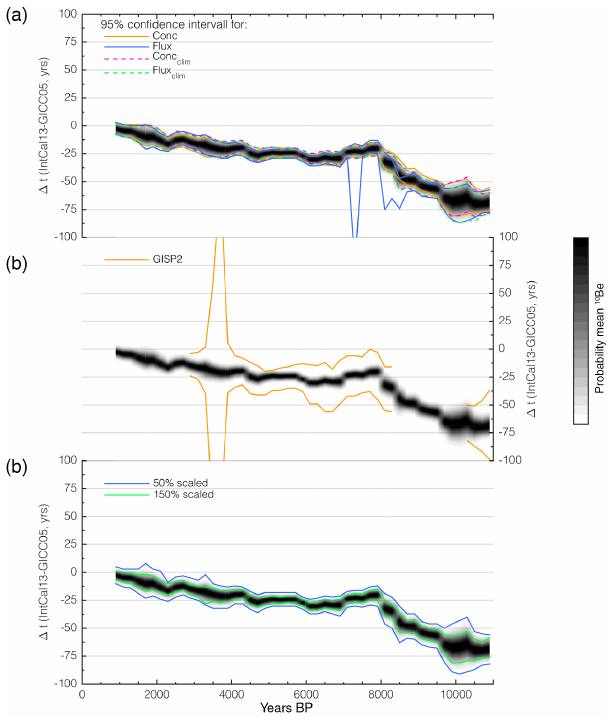
Figure 5. Probability distributions for IntCal13-GICC05 timescale differences ( P s ( t s ), see Sect. 2.1) for each 1000-year window scaled based on the mean of GRIP 10 Be concentrations, fluxes, and their climate corrected versions (grey-scale patches in all panels). The gap in the GRIP 10 Be record between 9400 and 10800BP has been filled with data from the GISP2 ice core. Each probability dis- tribution is centred on the mean age of the investigated window. (a) Comparison to 95% probability intervals based on GRIP 10 Be concentrations (solid orange), fluxes (solid blue) and their “climate corrected versions (dashed pink and green lines). (b) Comparison to 95% confidence intervals based on the mean of GISP2 10 Be con- centrations, fluxes, and their climate corrected versions. Results for GISP2 are only shown for periods where it has not been used to fill the gap in the GRIP record. (c) Comparison to results based on a different scaling (factors of 0.5 and 1.5 shown as blue and green lines, respectively) of the GRIP 10 Be